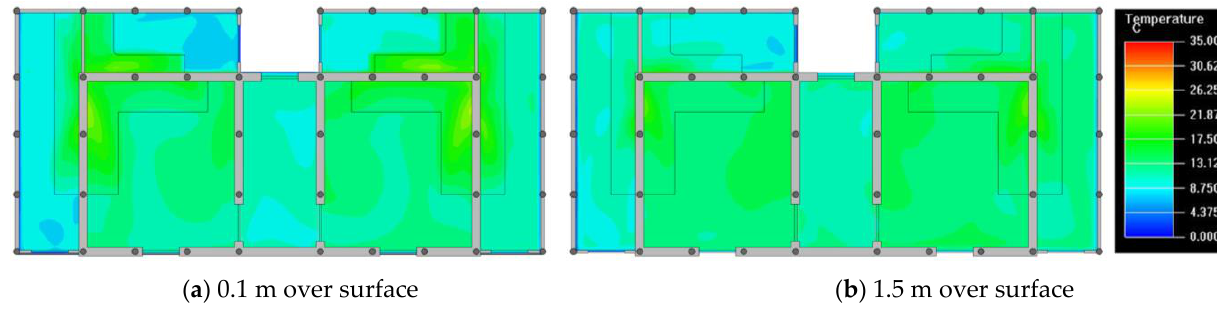
Figure 3. The indoor temperature of No. 4 Palace.